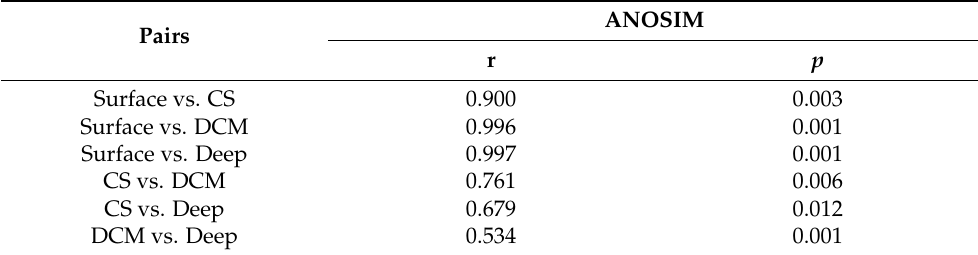
Table 1. ANOSIM tests of the groupings of protistan assemblages. Community turnover was based on the Bray–Curtis distance. Surface, surface waters; CS, coastal subsurface waters; DCM, deep chlorophyll maximum depth; Deep, deep waters. ANOSIM Pairs r p Surface vs. CS 0.900 0.003 Surface vs. DCM 0.996 0.001 Surface vs. Deep 0.997 0.001 CS vs. DCM 0.761 0.006 CS vs. Deep 0.679 0.012 DCM vs. Deep 0.534 0.001